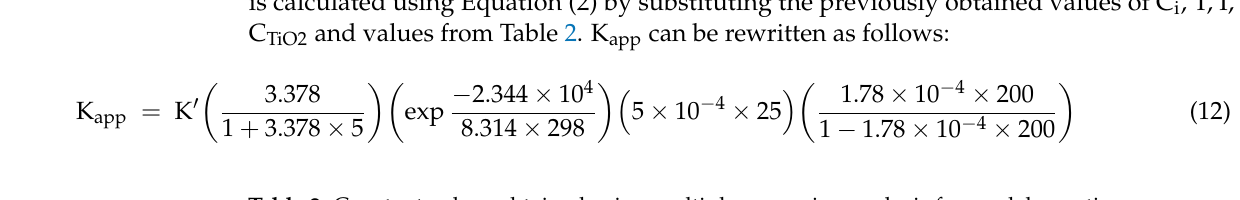
Table 2. Constant values obtained using multiple regression analysis for model equation.